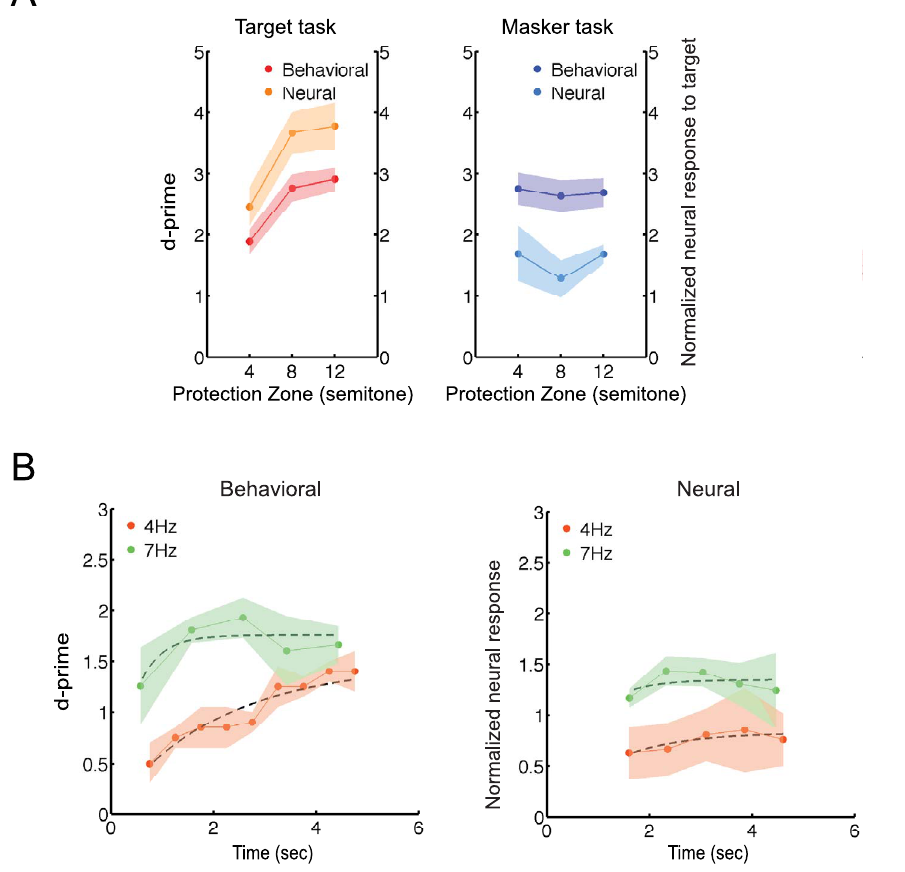
Fig. 4. Larger protection zones ease the target task, but not the masker task. (A) Behavioral performance and neural results (MEG experiment C, N 5 12) for the target task (left panel) and the masker task (right panel), as a function of protection zone. (B) Analysis of neural and behavioral build-up over time for the target task. Behavioral performance (left panel) and normalized neural responses, normalized with respect to the masker task neural response power (right panel) are plotted as a function of time for both the 4 and 7 Hz target sequence rate (orange and green curves, respectively), averaged over participants. Data shown for the 4 Hz target rate is obtained from the study by Elhilali et al. 2009. Neural responses and corresponding behavioral performances are acquired only for the 8 semitones protection